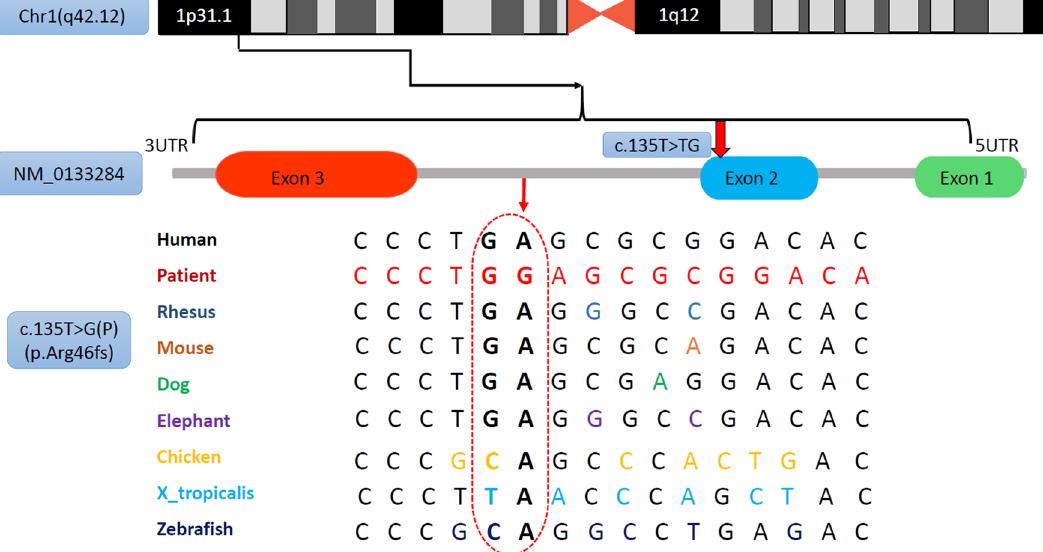
Fig. 4 Schematic description of the location of our novel variant in PYCR2 gene and multispecies alignment for the candidate variant throughout different